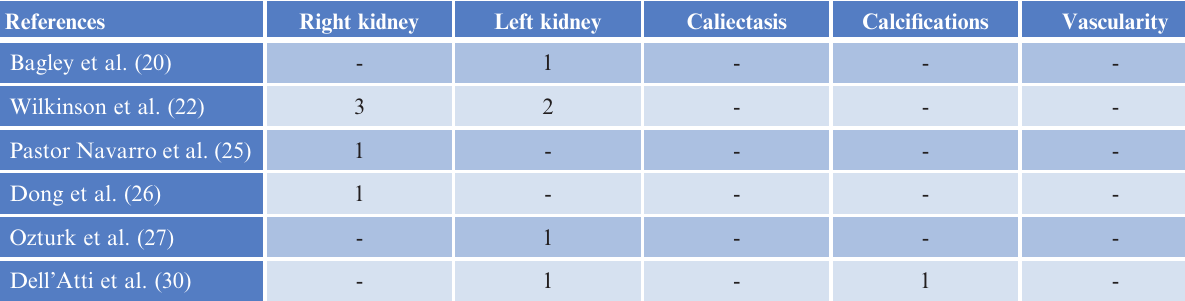
Table 2. US features of adult CN